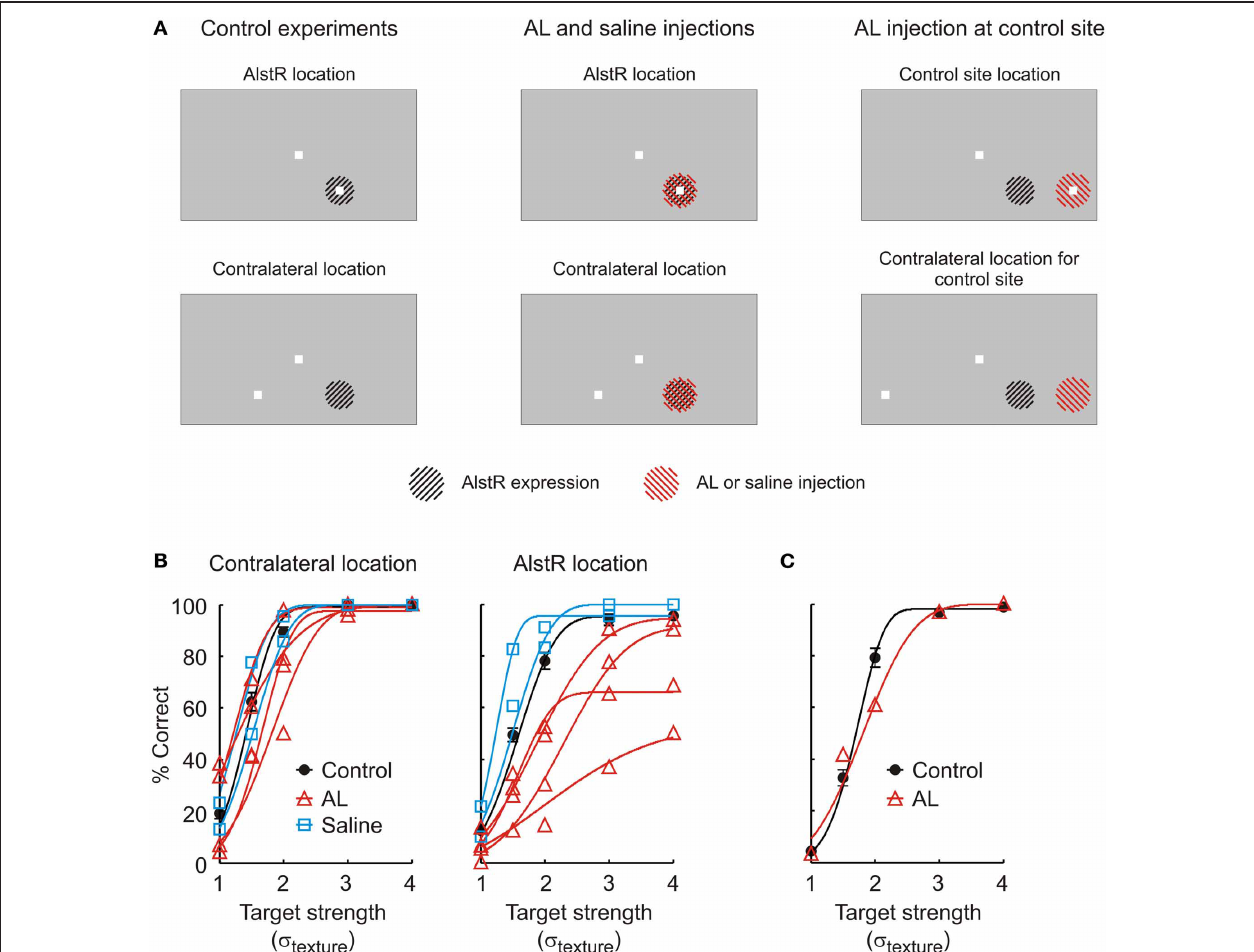
the AlstR location. Black circles: Average performance in control experiments without injection (error bars: SEM). Black line: Average psychometric function fit to the control data. Red lines and triangles: Performance in individual AL injection experiments (triangles: raw data; lines: psychometric function fit to the different injection experiments). Blue squares and lines: Performance (raw data and fit) during saline injection. (C) Performance during AL injection at a V1 site not expressing the AlstR. The target was placed to fall into the receptive field locations at this site (marked as “control site location” in A ). Black circles and line: Average behavior and psychometric function in control experiments without injection (error bar: SEM). Red triangles and line: Performance (raw data and fit) during AL